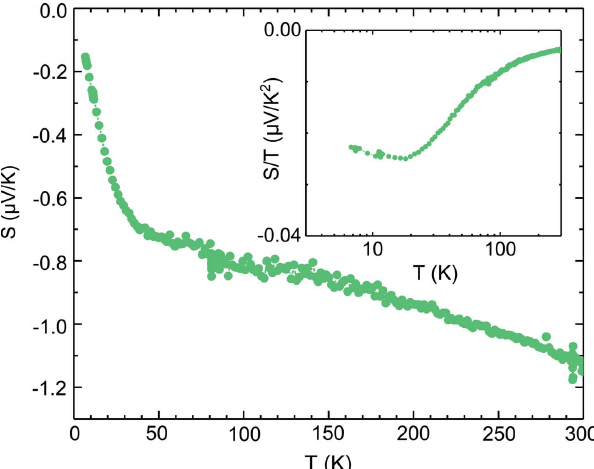
Figure 7 The temperature dependence of the Seebeck coefficient confirms the metallic character. The inset shows S / T , usually plotted for metallic